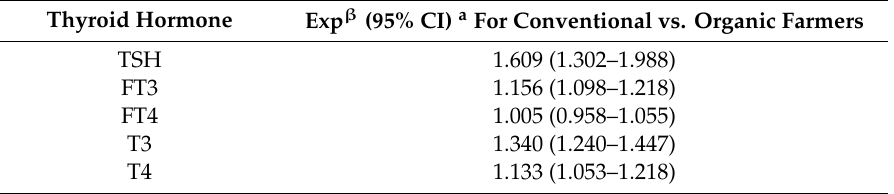
Table 3. Comparison of log(e) thyroid hormone levels for conventional farmers versus organic farmers using generalized linear